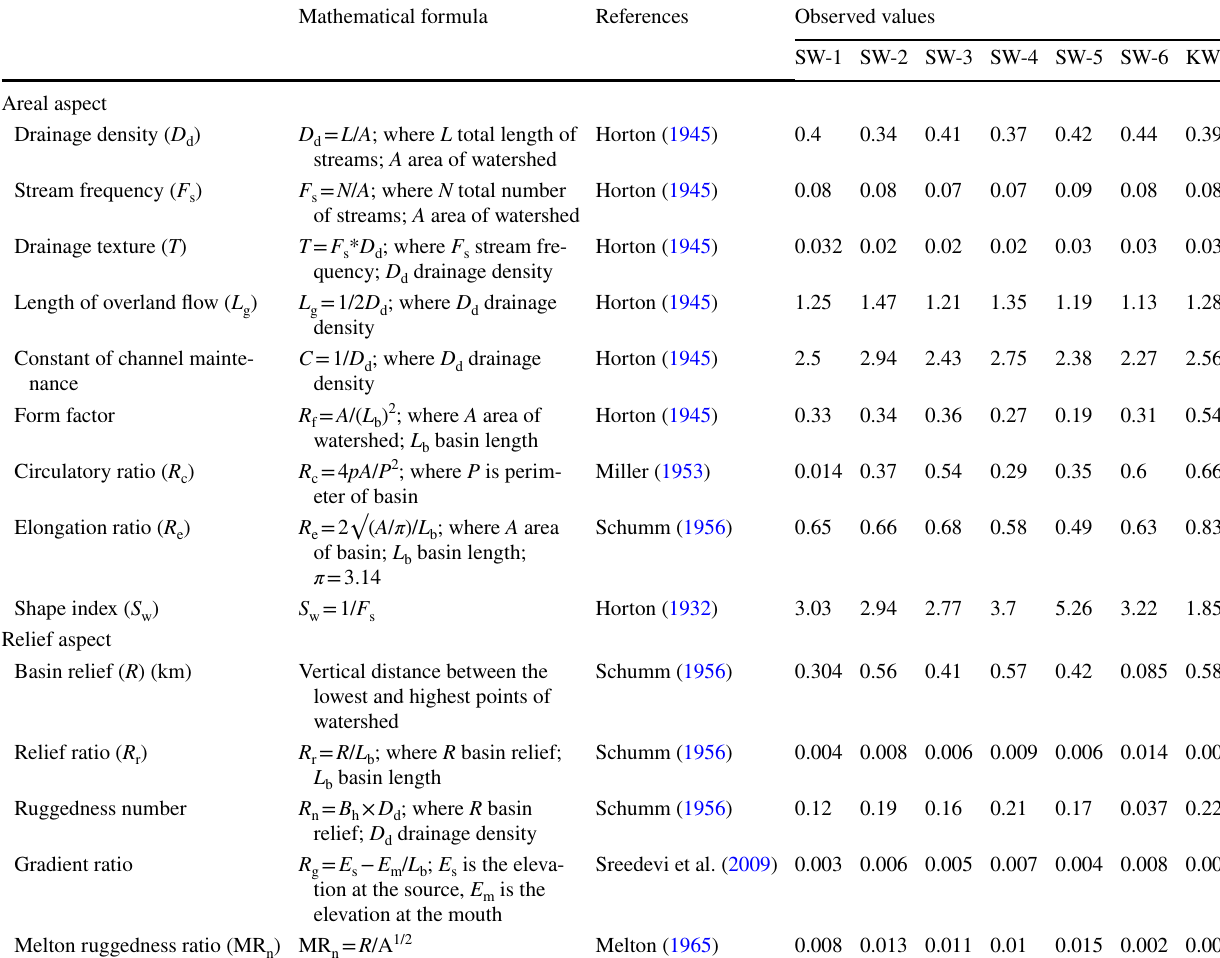
Table 2 Mathematical formulae and the calculated value of areal and relief parameters Mathematical